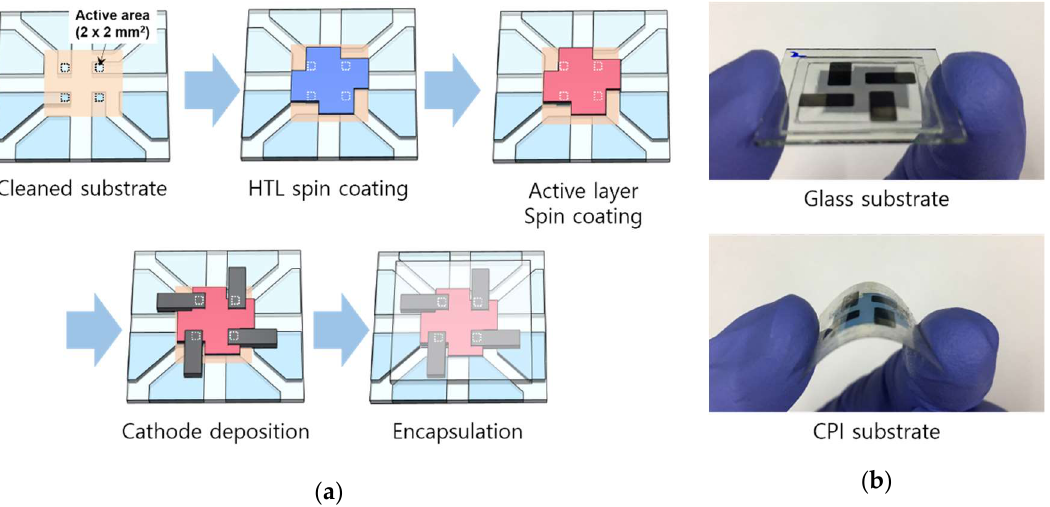
Figure 2. ( a ) Fabrication process of organic detector, and ( b ) images of fabricated detector on glass and CPI